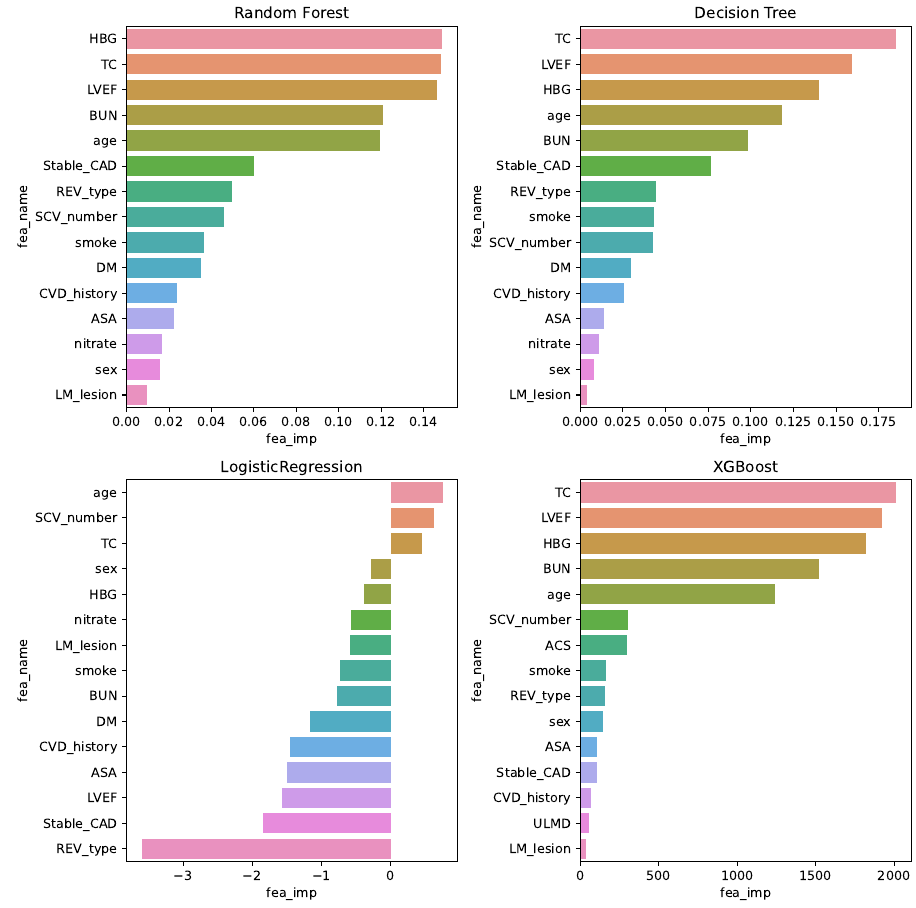
Figure 7. The feature importance of 4